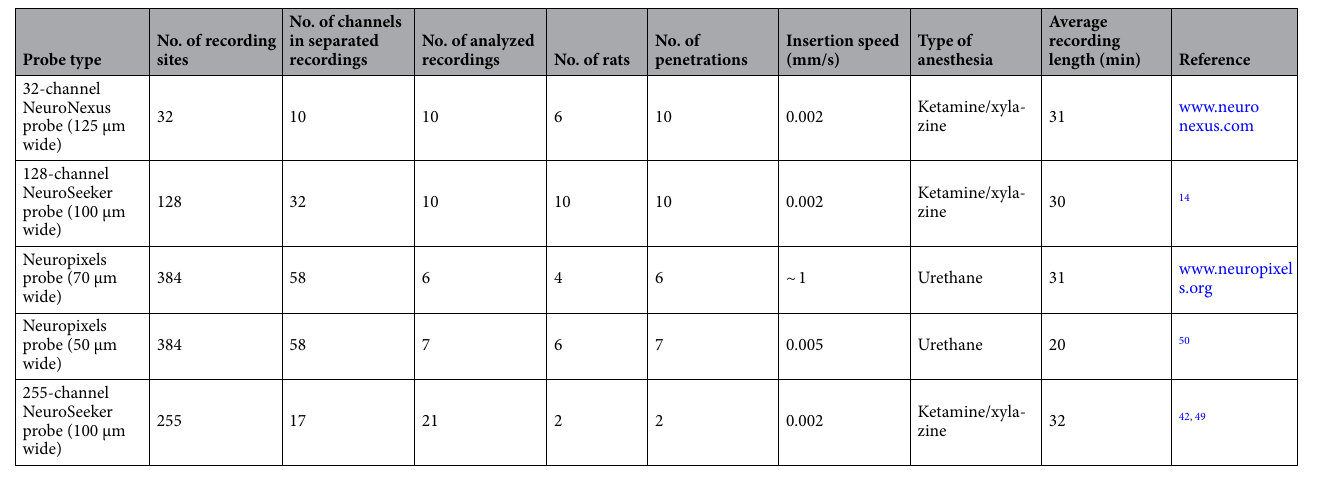
Table 1. Details of the experiments and recordings of the five silicon probe